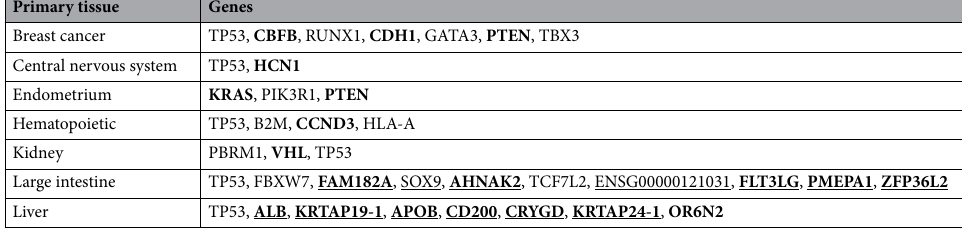
Table 4. Driver genes predicted for each of the cancer types. The genes reported showed consensus for > 4 CV models. Genes in bold did not find similar consensus in the pan-cancer predictions. New genes are